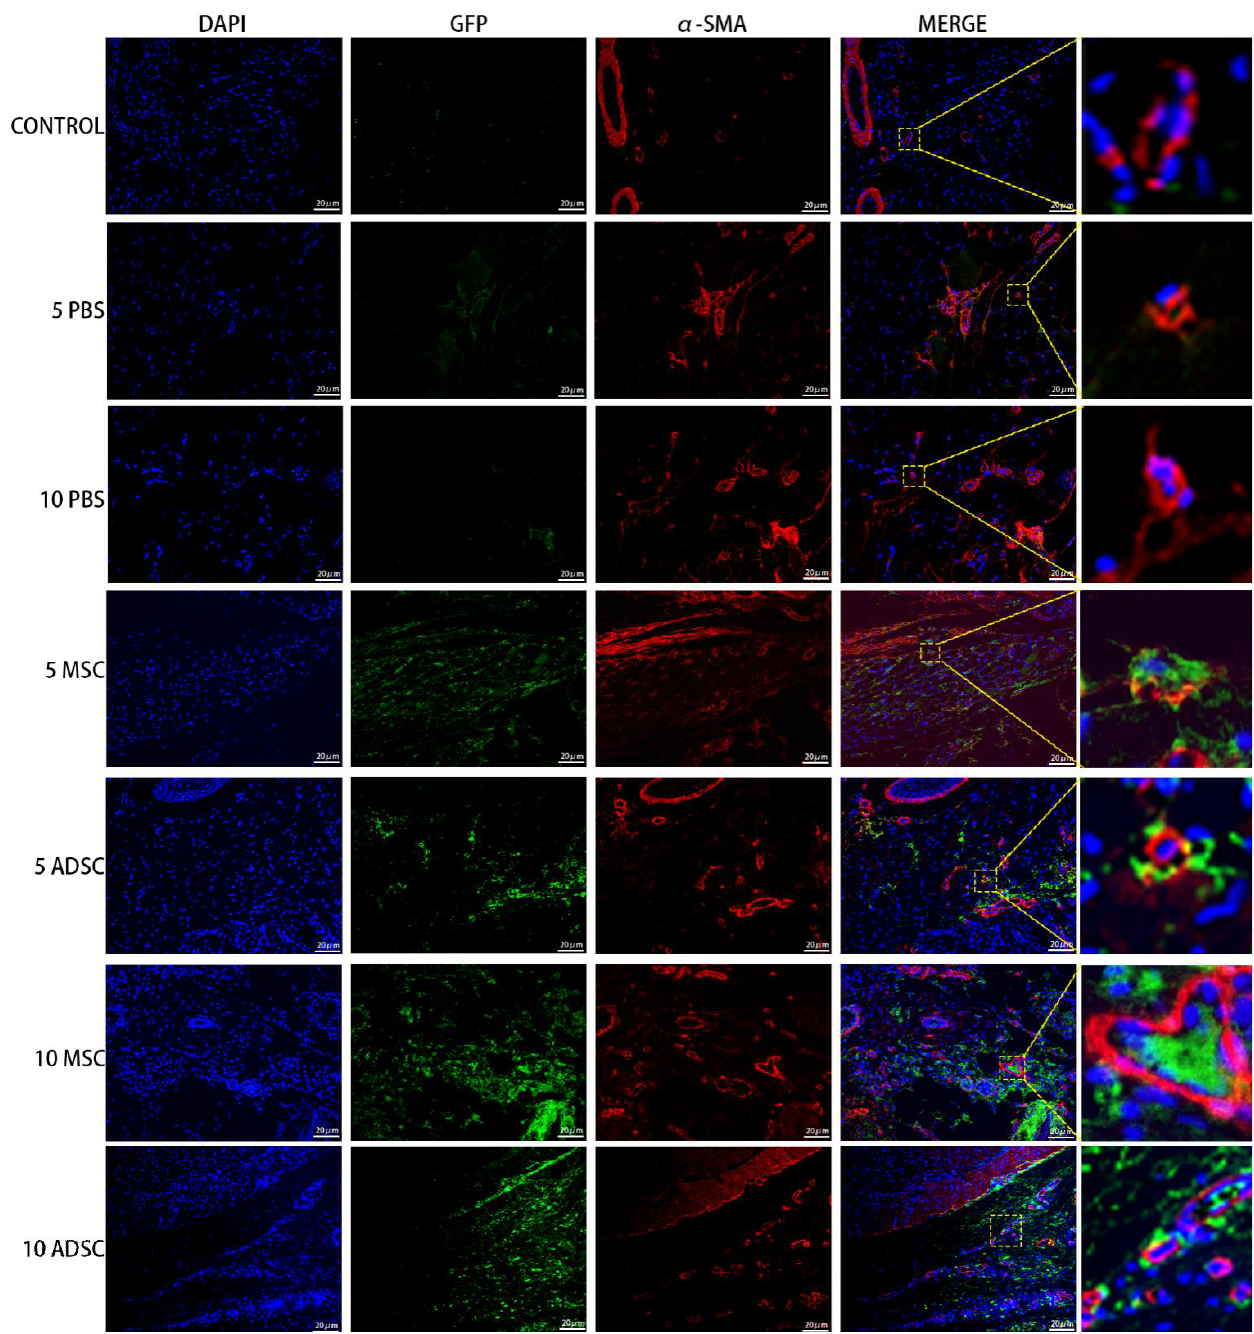
Figure 10. ADSC and MSC co- expressed GFP and α -SMA after 5 and 10 days of injection. The 1st to 7th row represents staining of GFP and α -SMA in the control group, PBS group on the 5th and 10th day, MSC and ADSC group on the 5th day, and MSC and ADSC on the 10th day, after the treatment.